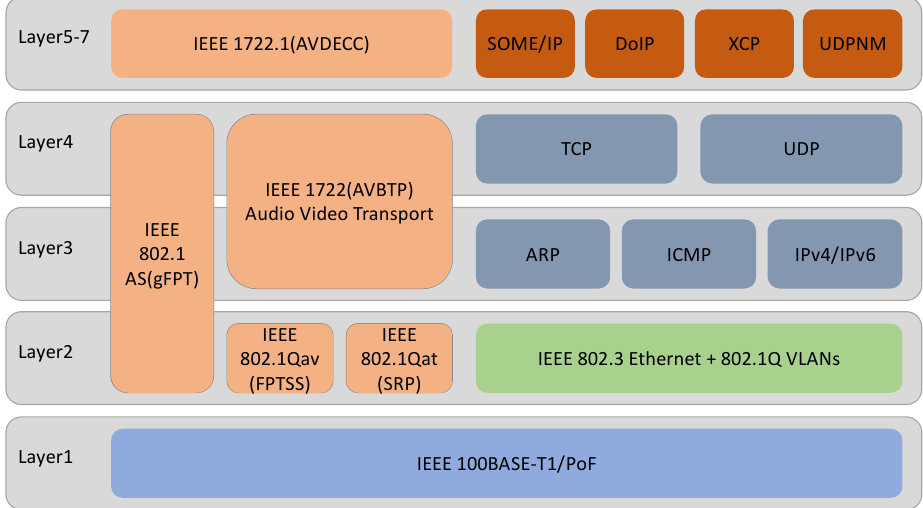
Figure 2. Frame structure and baud rate switch of CANFD: ( a ) CANFD frame structure with an 11-bit identifier; ( b ) baud rate switch of CANFD.